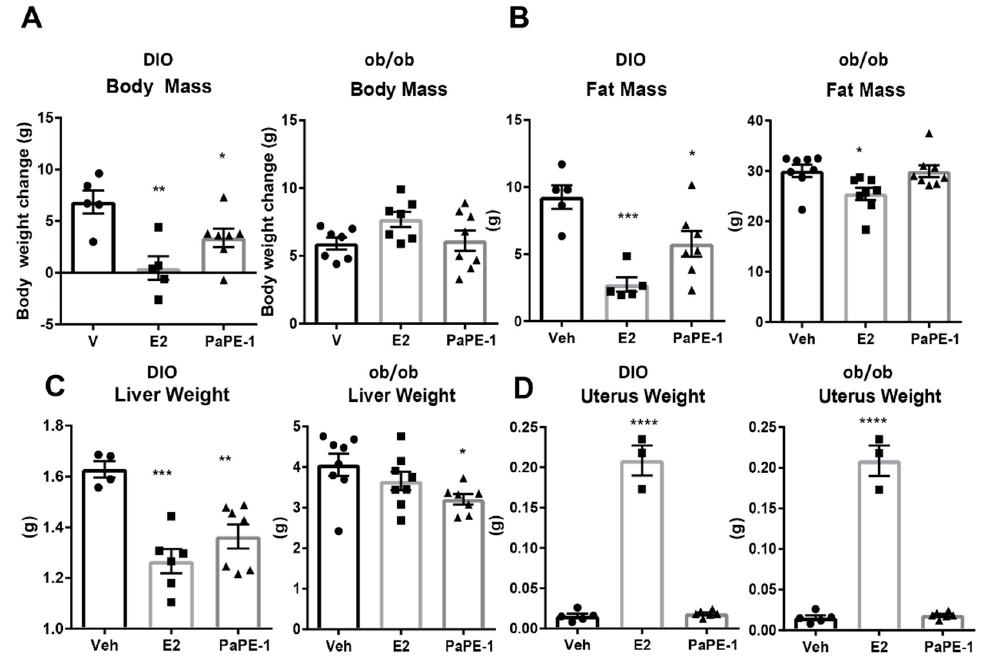
Figure 1. Body and organ mass of E2 and PaPE-1 treated diet induced obesity (DIO) and ob/ob mice. ( A ) PaPE-1 decreased weight gain caused by high-fat diet (HFD) in DIO mice, but not significantly in ob/ob mice. ( B ) E2 and PaPE-1 prevent fat mass increase caused by HFD but not in ob/ob mice. ( C ) The liver weight of both DIO and ob/ob mice showed that PaPE-1 was very effective at decreasing liver weight increase caused by HFD in DIO mice or leptin deficiency. ( D ) Unlike E2 treatment, PaPE − 1 does not increase uterus weight in both DIO and ob/ob mice. Statistical significance was established at α = 0.05. All weights were normally distributed. Pairwise t − tests with a Bonferroni correction were used to identify treatments that were significantly different from each other (* p < 0.05, ** p < 0.01, *** p < 0.001, **** p < 0.0001).